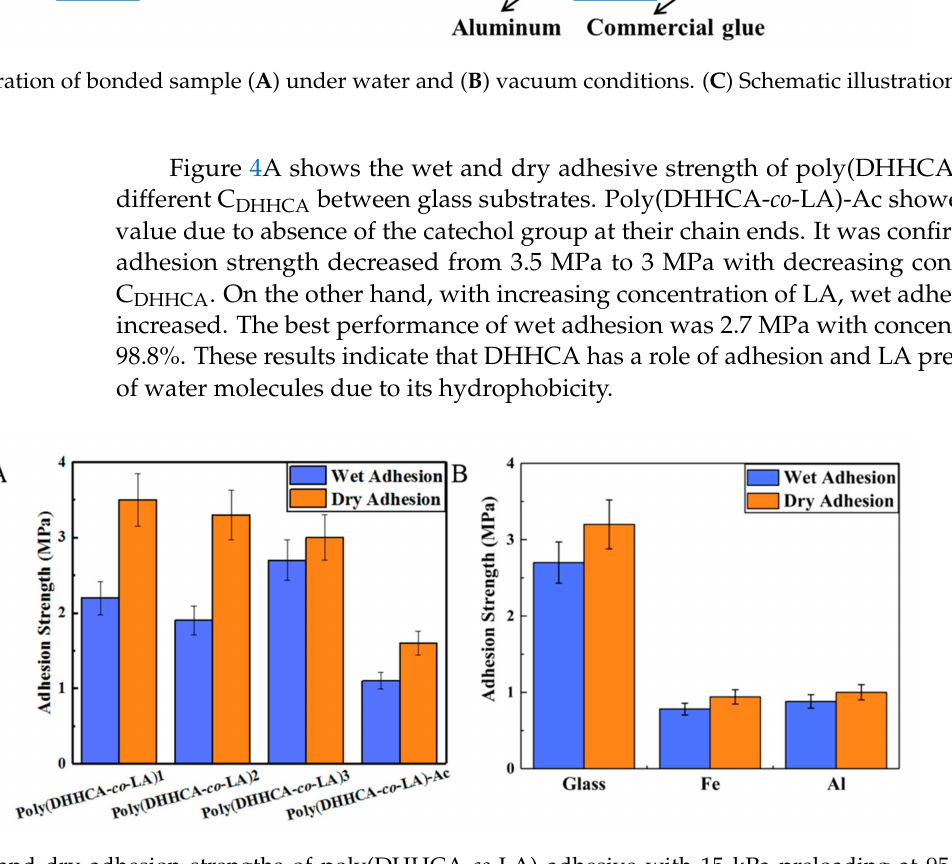
Figure 4. Wet and dry adhesion strengths of poly(DHHCA- co -LA) adhesive with 15 kPa preloading at 95 ◦ C melt- ing temperature. ( A ) Different C DHHCA of poly(DHHCA- co -LA)1, poly(DHHCA- co -LA)2, poly(DHHCA- co -LA)3 and poly(DHHCA- co -LA)-Ac between glass substrates. Each C DHHCA is summarized in Table 1. ( B ) Dry and wet adhesion strength of poly(DHHCA- co -LA)3 with 15 kPa preloading at 95 ◦ C melting temperature on different substrate materials; glass, steel and